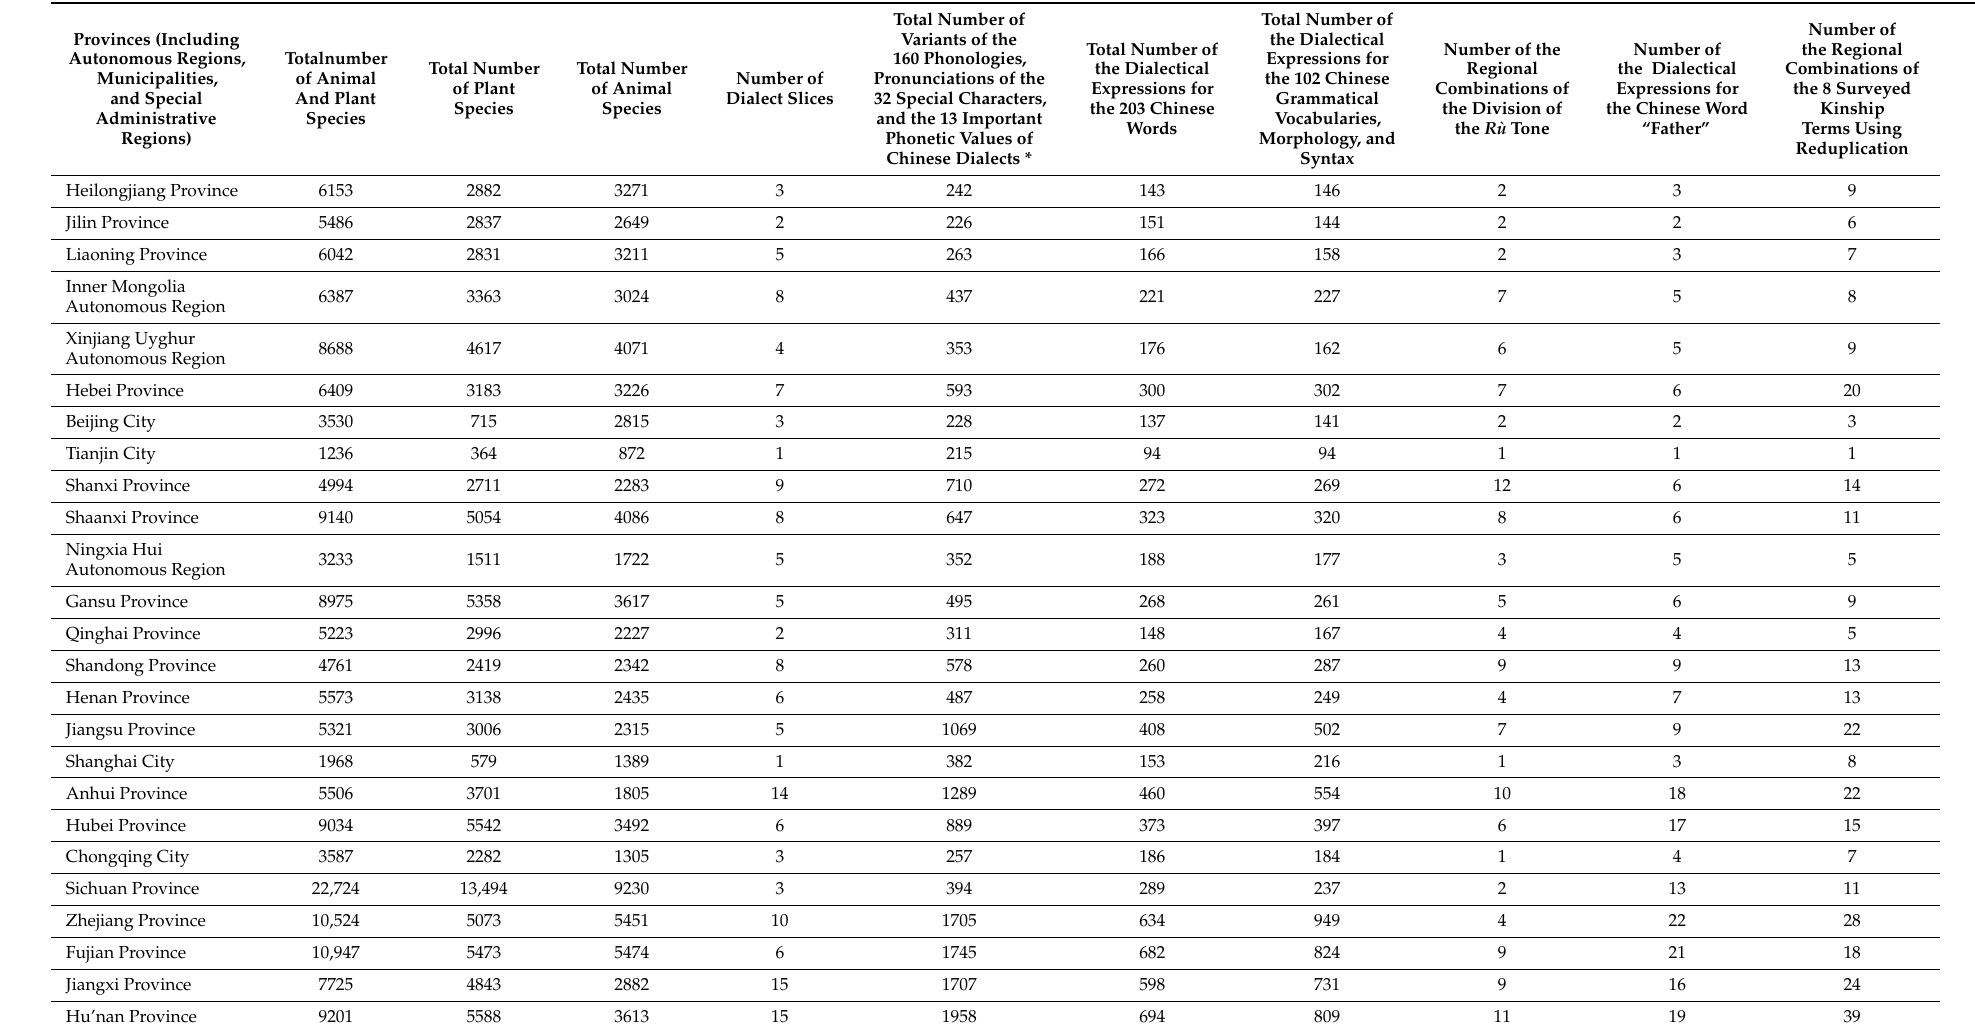
Table 1. Statistical indicators of biodiversity and Chinese